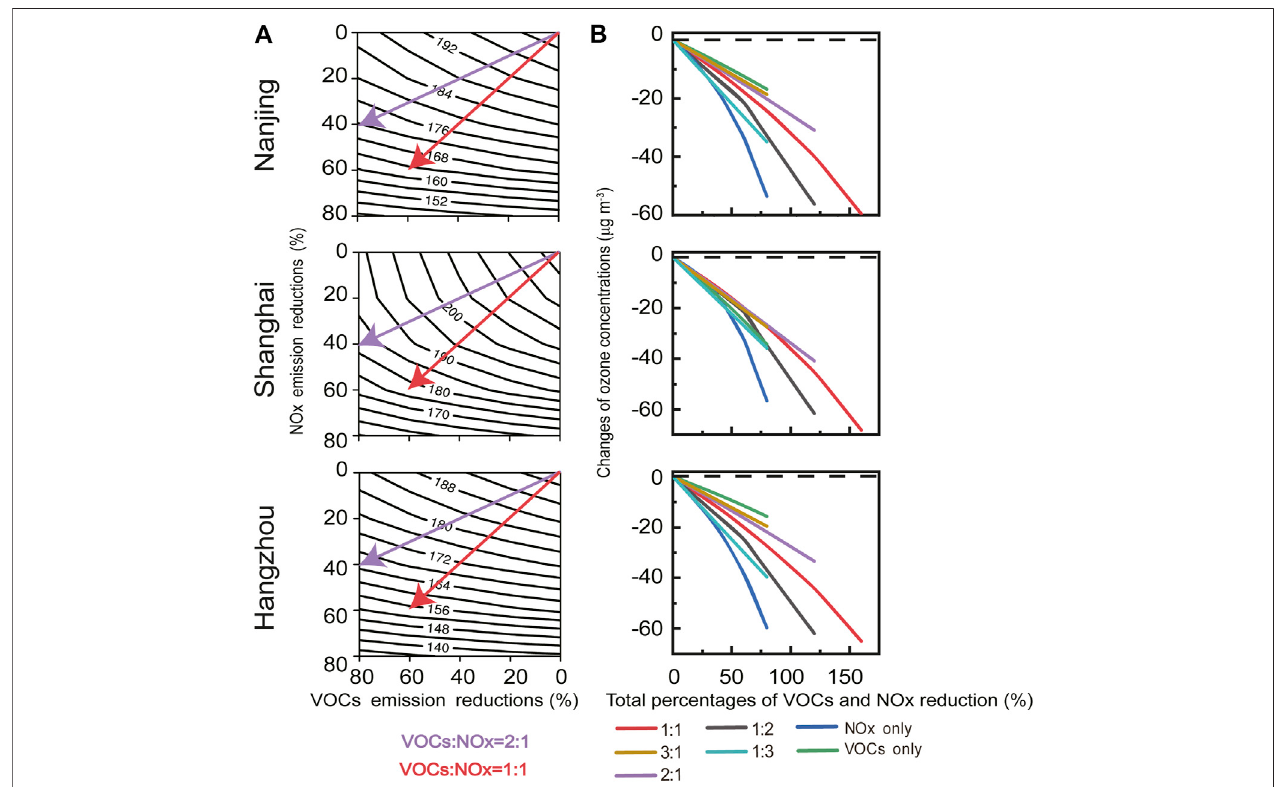
FIGURE 8 | Same as Figure 4 , but for high pollution events from July 22 to 27, 2017 in Nanjing, Shanghai, and Hangzhou,